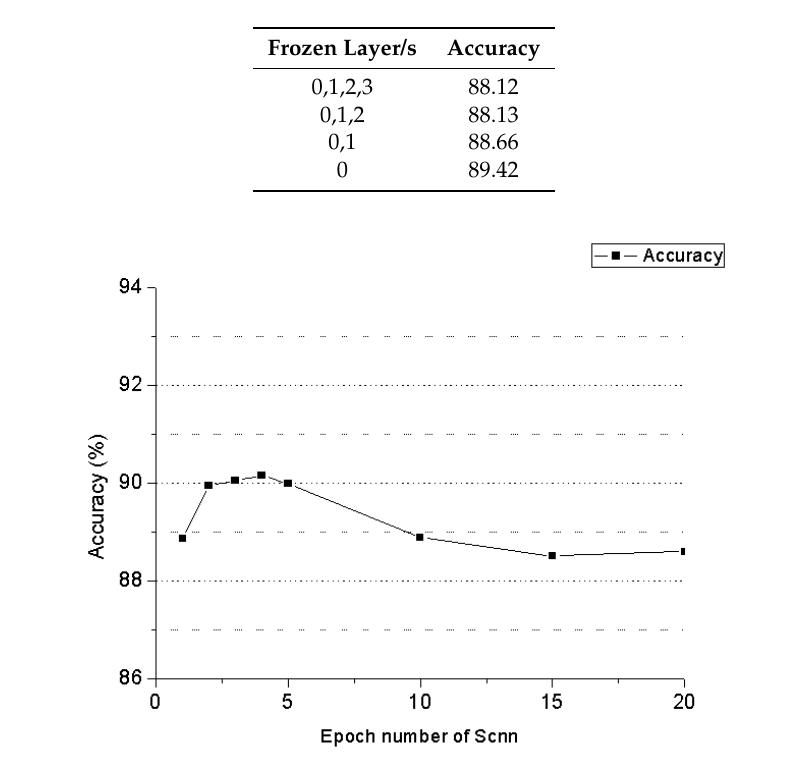
Table 5. Main results of LM-CNN-LL62k for freezing different layers.